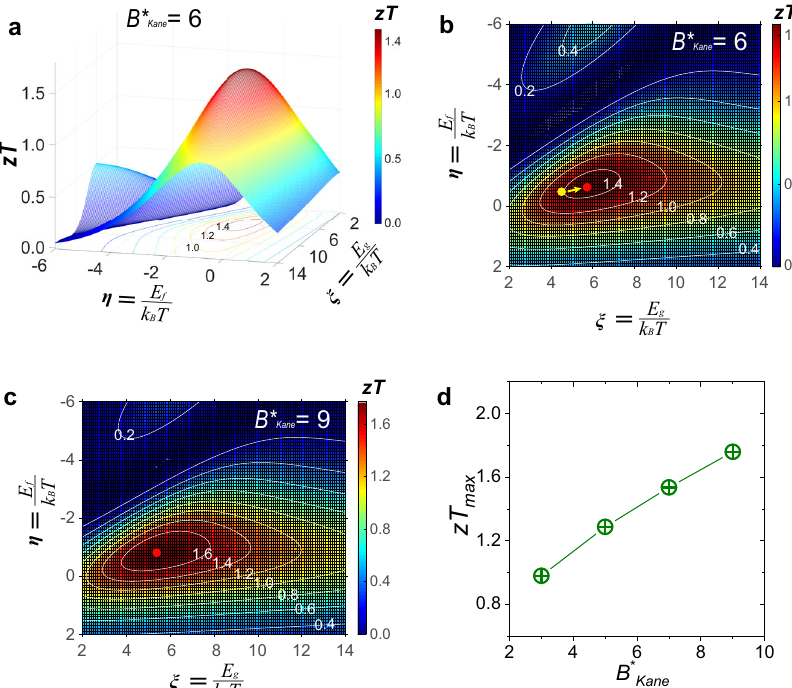
Fig. 4 Quality factor analysis. a 3D plot of fi gure of merit, zT as functions of reduced Fermi level, η and reduced band gap, ξ . b Contour plot of η - and ξ - dependent zT with a quality factor, B * Kane = 6. The yellow dot corresponds to the experimental data of Pb 7 Bi 4 Se 13 with n H of 1.2 × 10 20 cm − 3 (Ga2). The red point indicates the highest zT value. Contour lines in white color correspond to a series of zT values. c Contour plot of η - and ξ -dependent zT with B * Kane = 9. d The maximum zT ( zT max ) as a function of B * Kane